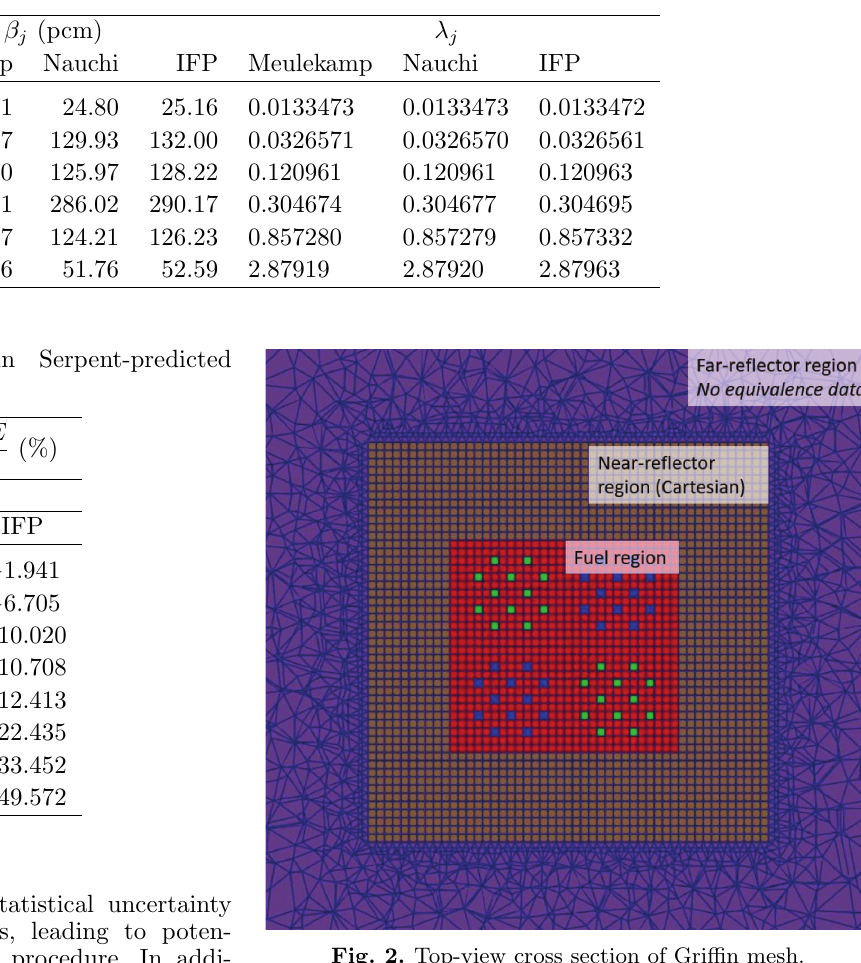
Table 5. Serpent-predicted delayed neutron data.